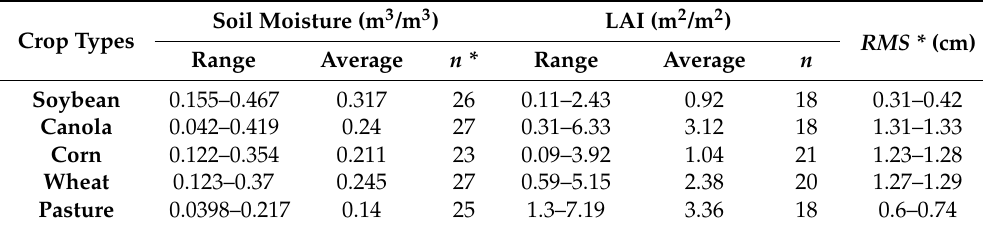
Table 2. The in-situ soil moisture (0–5 cm) and Leaf Area Index (LAI) data used in this study.